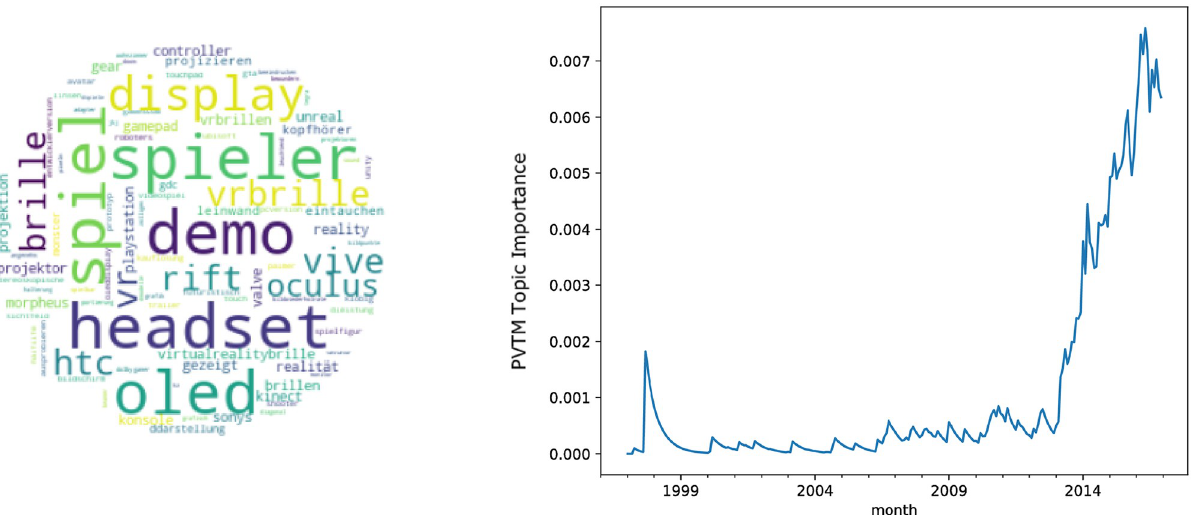
Fig 5. Topic virtual reality. A: Most relevant words. B: Monthly observations of the topic importance over time, smoothed using a 12-month exponentially weighted moving average.